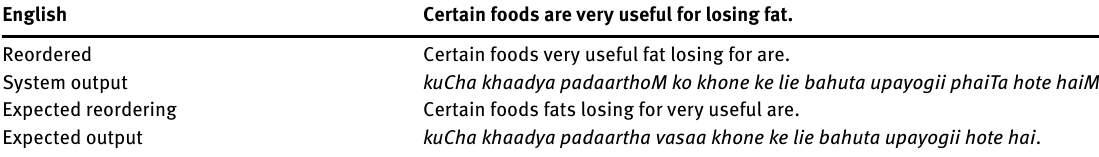
Table 8: Reordering Errors.